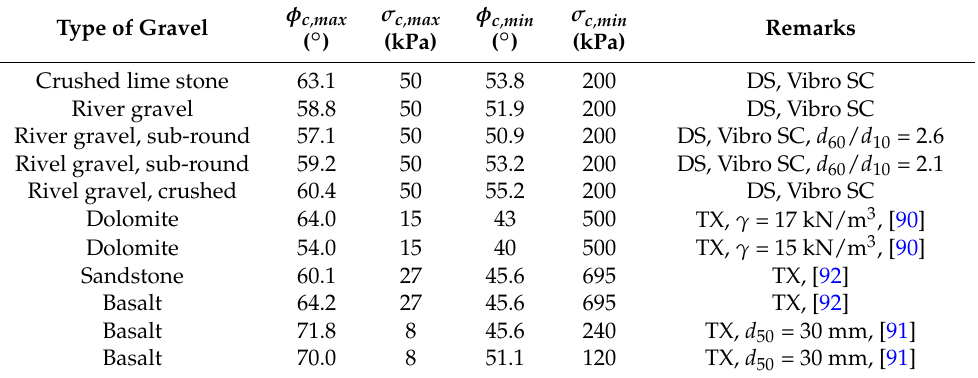
Table 2. Stress-dependent peak friction angles of dense gravel